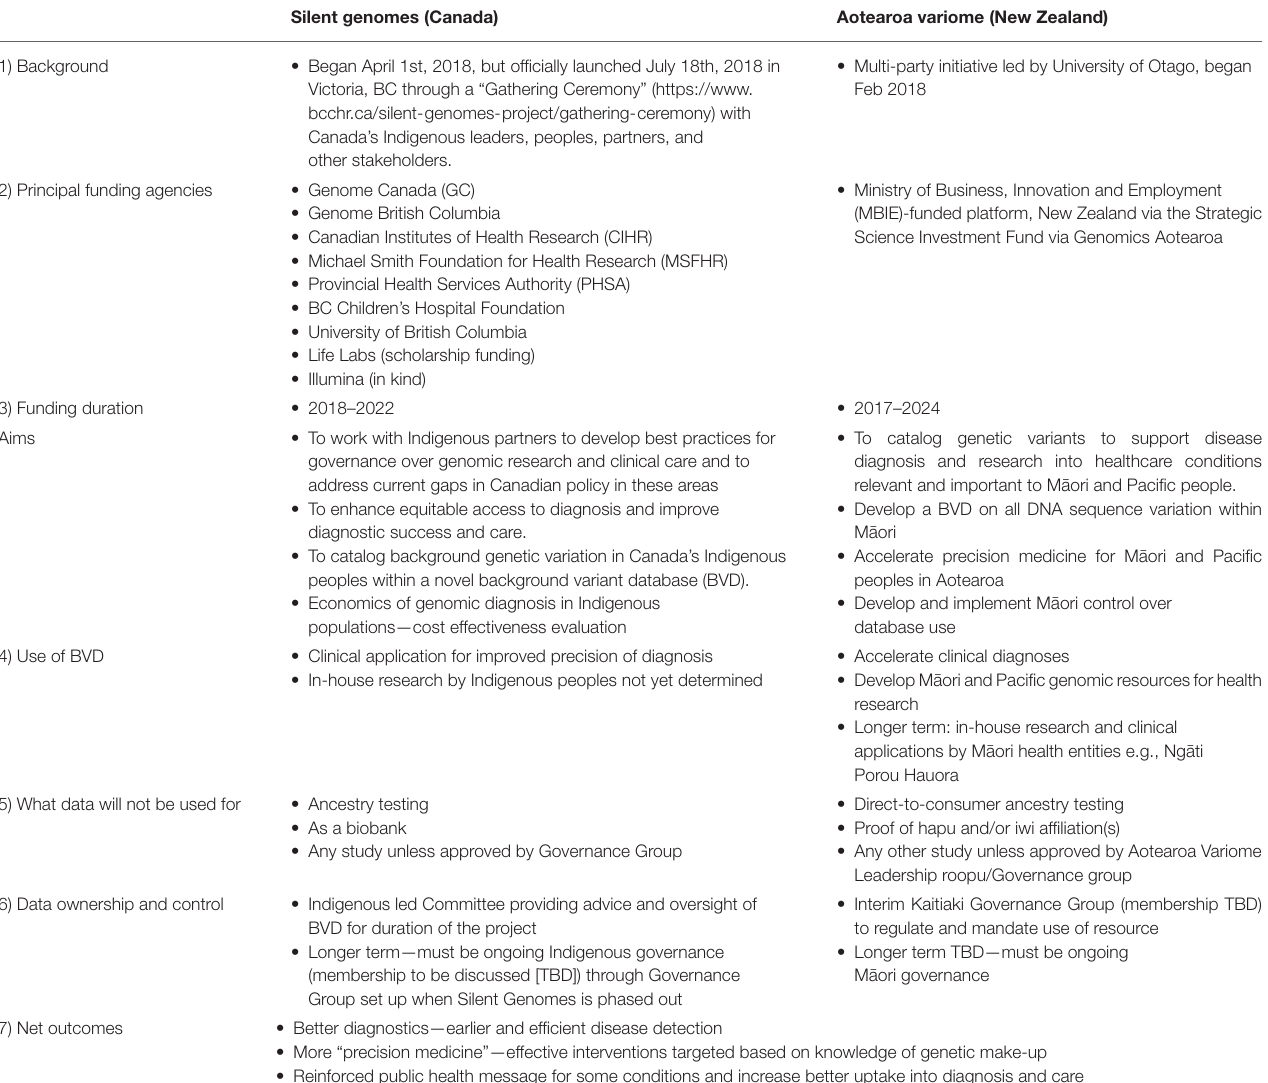
TABLE 1 | Silent Genomes and the Aotearoa Variome projects: in